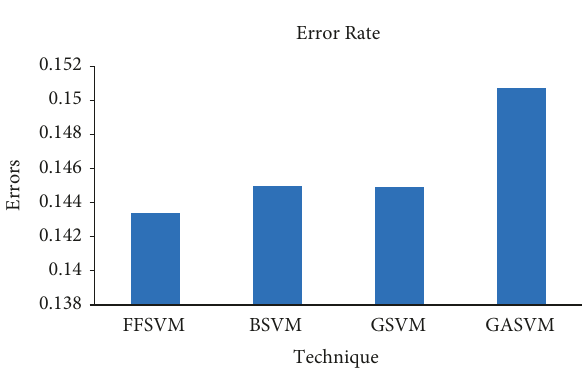
Figure 5: Comparison of error rates between the proposed al- gorithm and three other search algorithms (BSVM, GSVM, and GASVM). The error rates of the BSVM and GSVM algorithms are about to 14.50%. However, in the case of the GASVM algorithm, which has a high error rate (15.07%), it means the performance of a fraud detection algorithm can be decreased. The proposed algo- rithm has achieved a much lower error rate (14.34%). It means that the financial fraud detection correctness is high, and the most accurate way to detect fraud is by FFSVM.